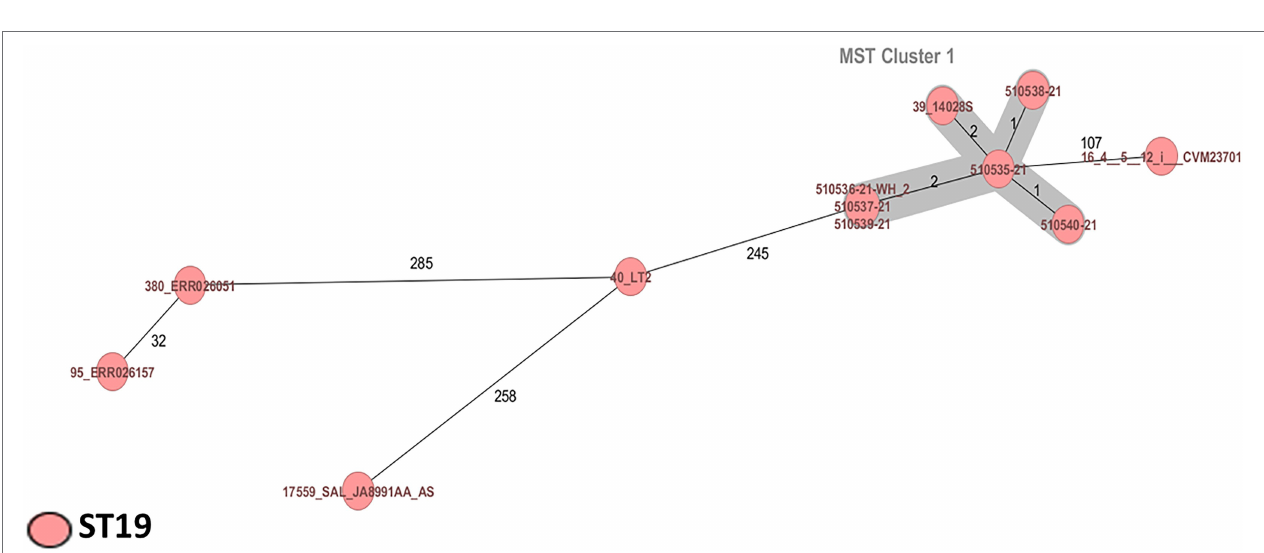
FIGURE 2 | Minimum spanning tree of six Salmonella Typhimurium strains from powdered infant formula manufactured in Mexico and supplemented with other S . Typhimurium ST19 strains of clinical and food origin. Calculation of the MST was based on the defined cgMLST scheme comprising 3,002 target genes for Salmonella. Isolates are represented as colored circles according to the classical MLST. Black numbers according to the allelic differences between isolates. Isolates with closely related genotypes are marked as